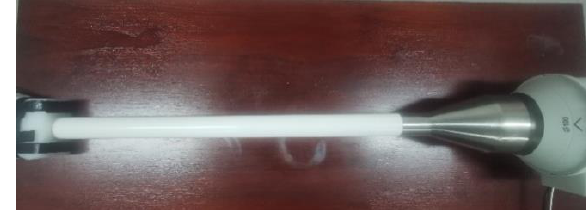
Fig. 7. Simulate tunnel environment.